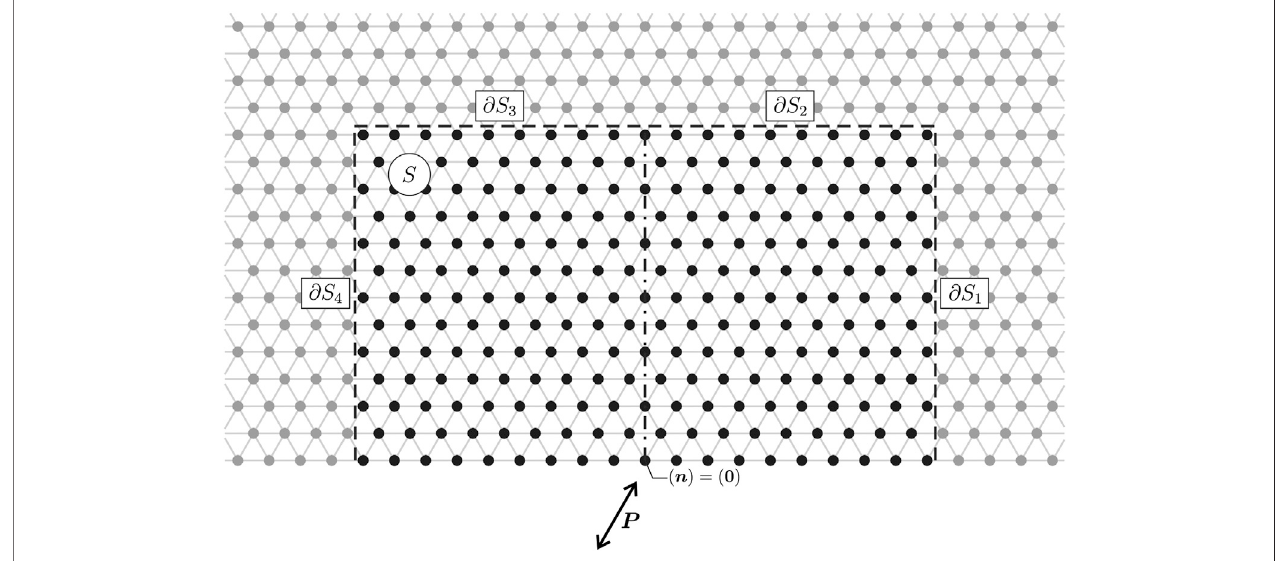
FIGURE5| Region S ofthegyroscopiclattice,delimitedbythehalf-planeboundaryandthesegments z S i ( i (cid:1) 1 , ... , 4),throughwhichtheenergy fl owiscalculated.